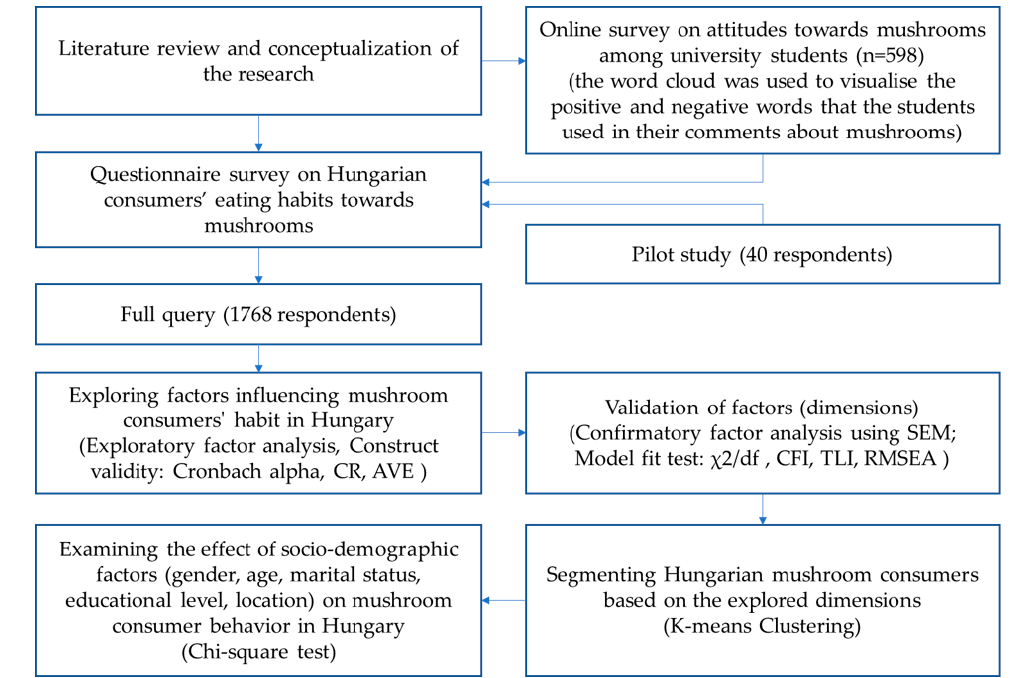
Figure 1. Research framework for examining factors influencing consumer behavior towards mushrooms in Hungary.